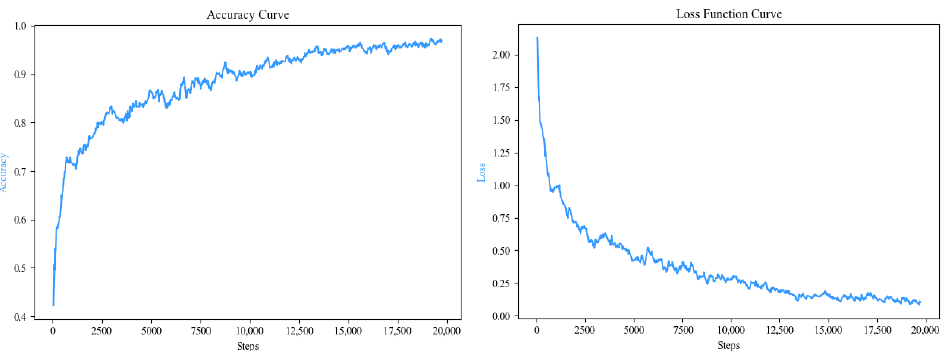
Figure 4. Accuracy curve and loss funtion curve.